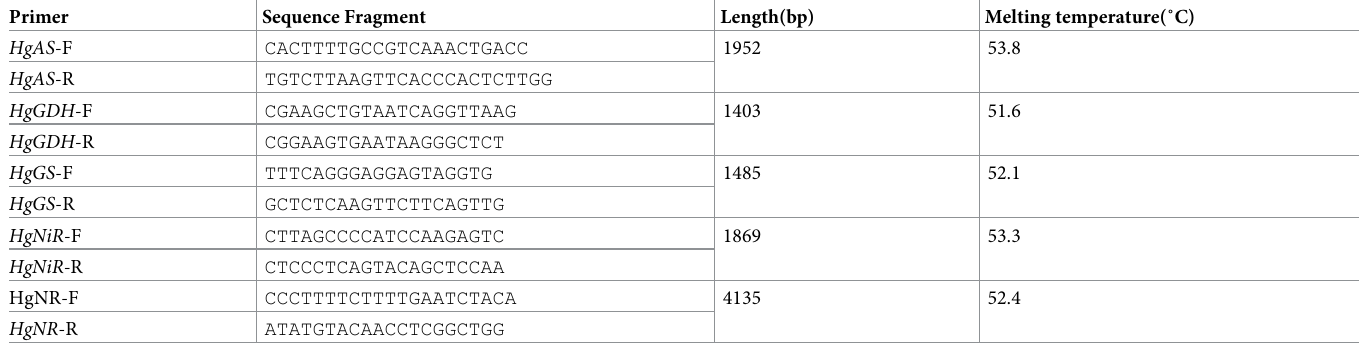
Table 2. Primers used for analysis of the expression of HgNR , HgNiR , HgGS , HgGDH , and HgAS